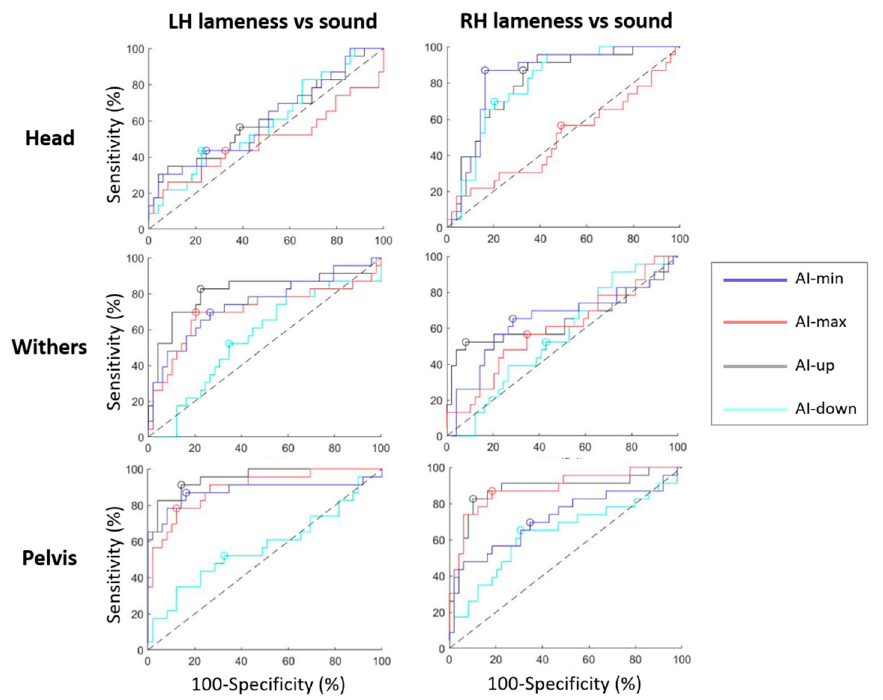
Figure 5. ROC curves discriminating horses with left hindlimb (LH) lameness from sound horses; and discriminating horses with right hindlimb (RH) lameness from sound horses, plotted for each sensor location (head, withers, pelvis); and plotted for asymmetry indice : AI-min (blue), AI-max (red), AI-up (black), and AI-down (cyan). The best specificity and sensitivity point of each curve is represented by a circle. The dashed black line is the hypothesized ROC curve with discrimination capacity only due to perfect chance. Table 4. Area under the curve (AUC) of the receiver operating characteristic (ROC) curve discrimi- nating sound and hindlimb lame horses, for each asymmetry indice (AI). Best sensitivity, specificity and associated threshold were calculated using top-left method of ROC analysis. [95% Confidence Interval] were calculated plotting ROC analysis on 400 population resamplings (bootstraps). Results for which the sum of sensitivity and specificity is over 150% for both sides are in bold. AI